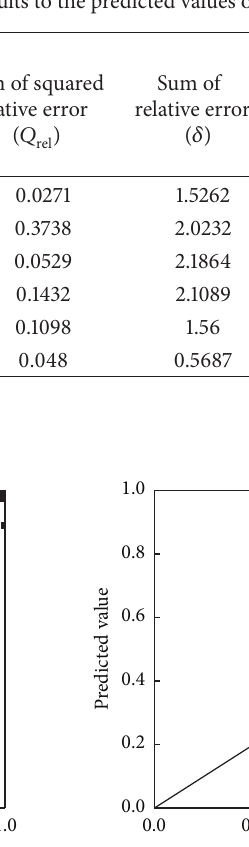
Table 2: Fit of experimental results to the predicted values of a single model.